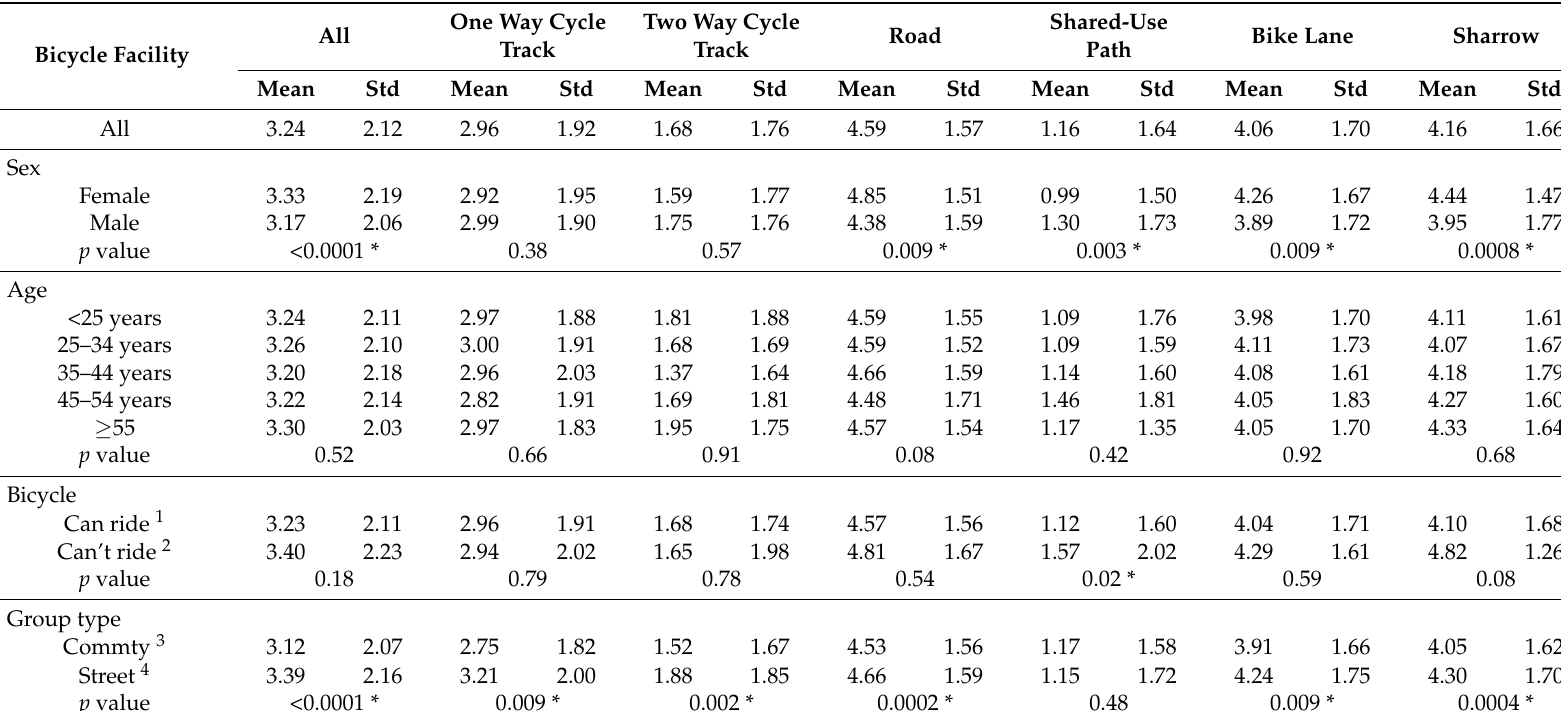
Table 4. Summary statistics for perceptions of crash for each of the six bicycle facility types, stratified by sex, age, bicycle, and group type.